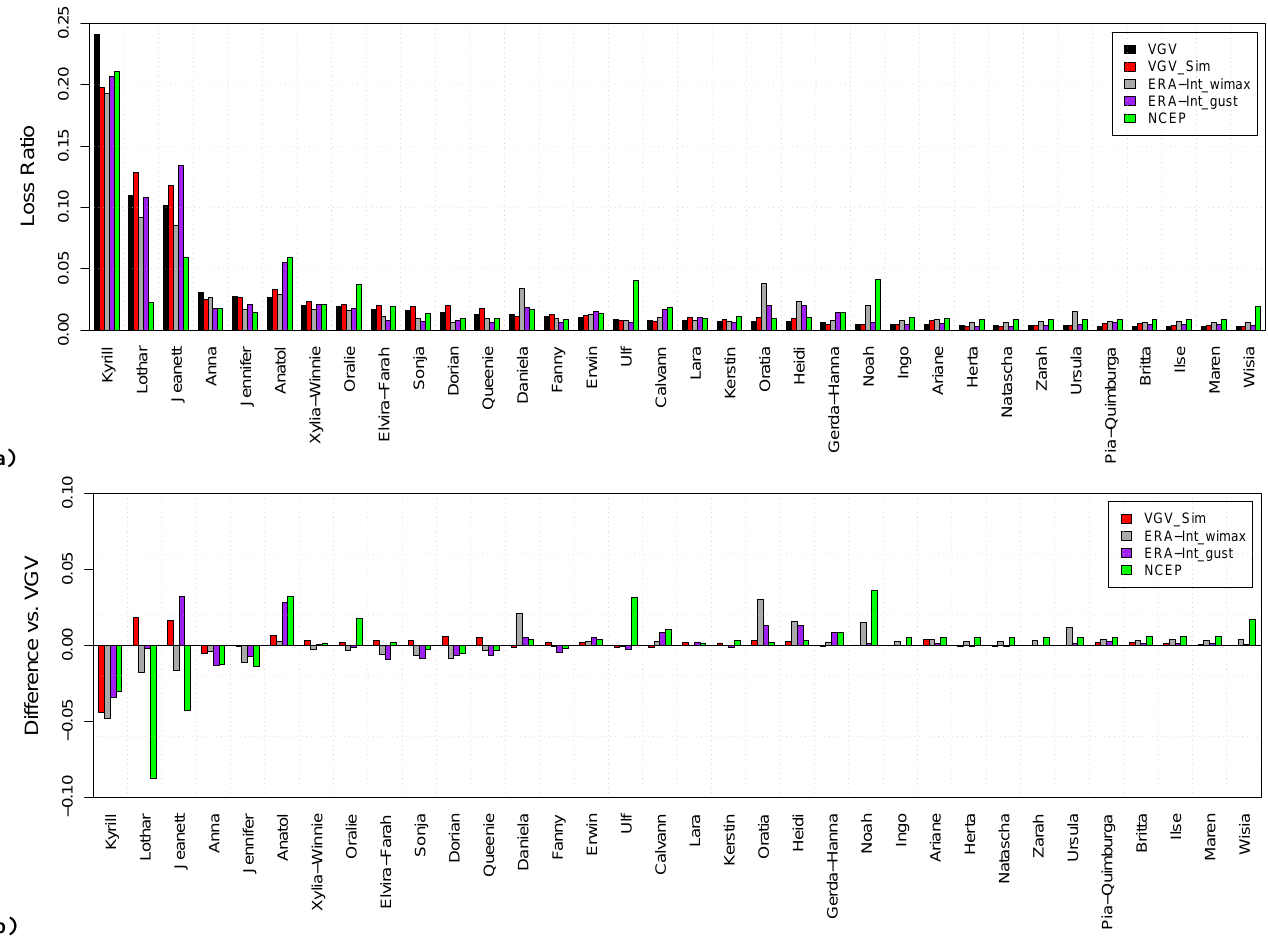
Fig. 5. Germany-wide cumulated losses for the 34 major loss events in the period 1997–2007 used for calibration of the loss model (unit: ‰). (a) For each event, the loss ratio is displayed on the basis of insurance losses to residential buildings (VGV, black bar), derived from vehicle insurance data (VGV Sim, red bar), and calculated from the different reanalysis wind data: ERA-Interim maximum wind speed (grey), ERA-Interim maximum gust (purple), and NCEP maximum wind speeds (green). The losses for ERA-Interim and NCEP are calculated based on linear regressions derived from the other 33 events, excluding this particular